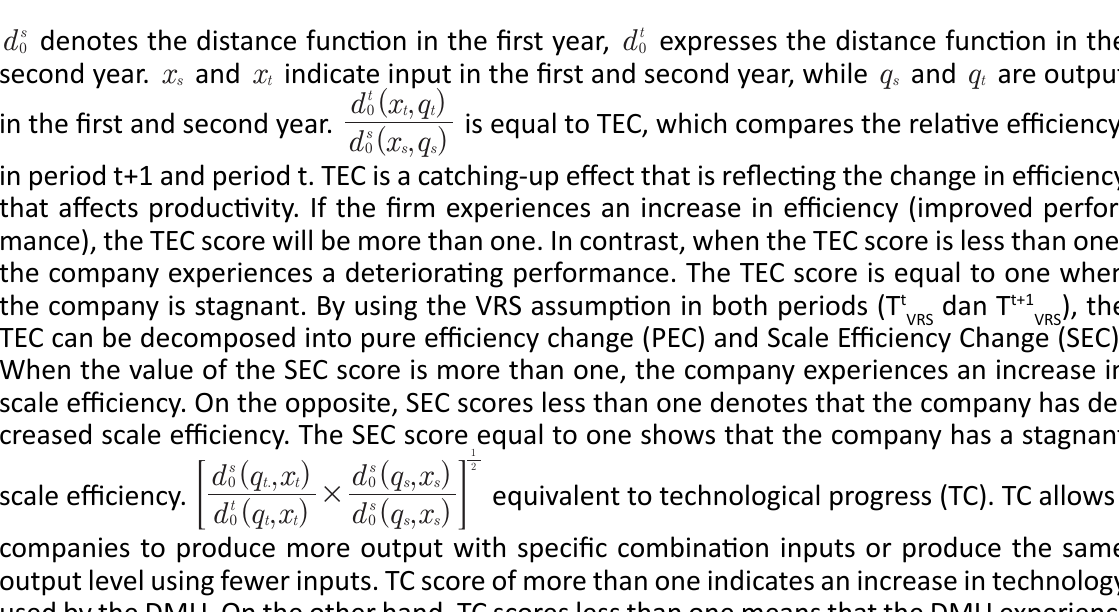
Table 2: DEA Bootstrapping Estimation Results on ASEAN-5 Telecommunications Industry Countries DMU